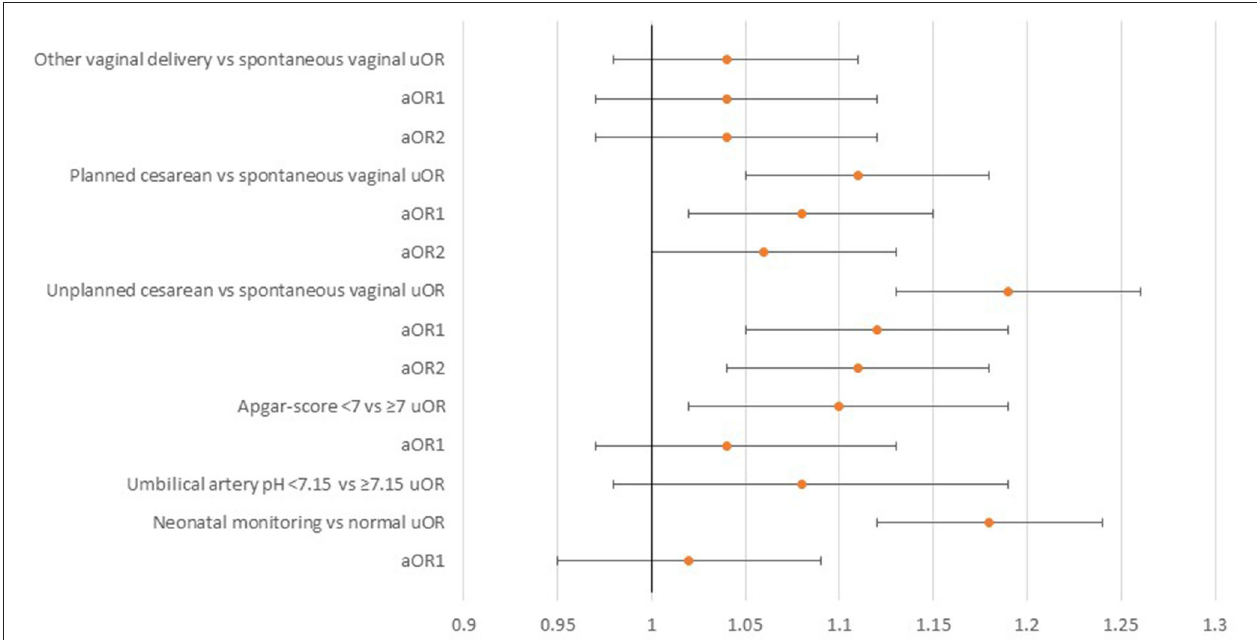
FIGURE 2 | The associations between mode of delivery, birth outcomes, and anxiety